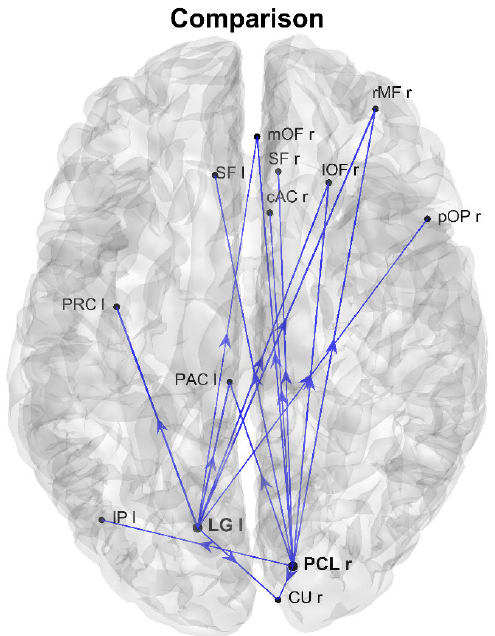
Figure 5. Network showing the differences between the normalized connections in the two groups, with reference to the connections that exit from the AQ-modulated source ROIs identified in Figure 1, with the exclusion of TPr, not significant in Figure 3. Only differences with an absolute value higher than 0.025 are shown. Blue lines denote connections higher in the group with higher autistic scores (AQ score ≥ 17). The presence of two nodes (LG left and PCL right) with stronger output connectivity is evident in the group with higher autistic traits.